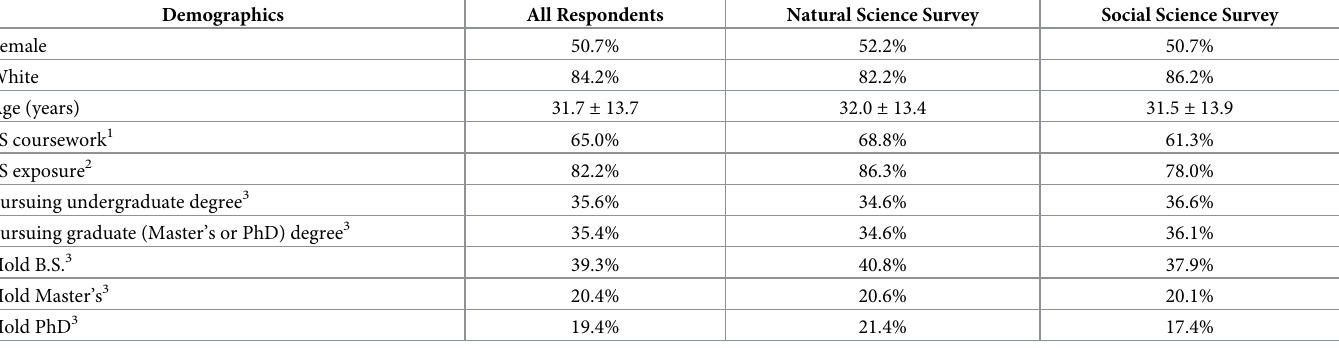
Table 1. Demographics of survey respondents. Respondents (n = 449) were earth scientists attending a 2015 professional conference. Approximately half of the respon- dents (n = 233) reported their perceptions of natural science and the other half (n = 216) reported their perceptions of social